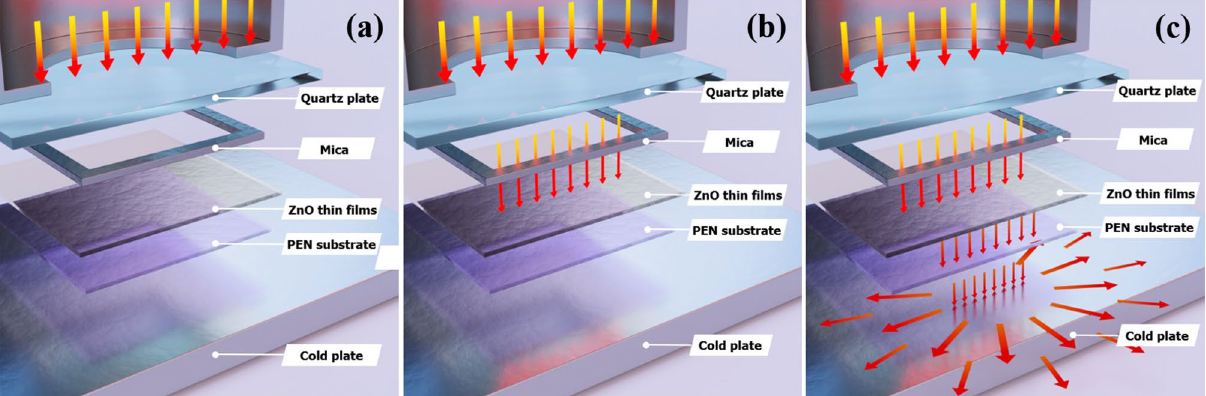
Figure 2. Schematics images for annealing process of TDA method composed of three steps: (a) generation of thermal energy, (b) flow of thermal energy, and (c) dissipation of thermal energy. The schematic images were